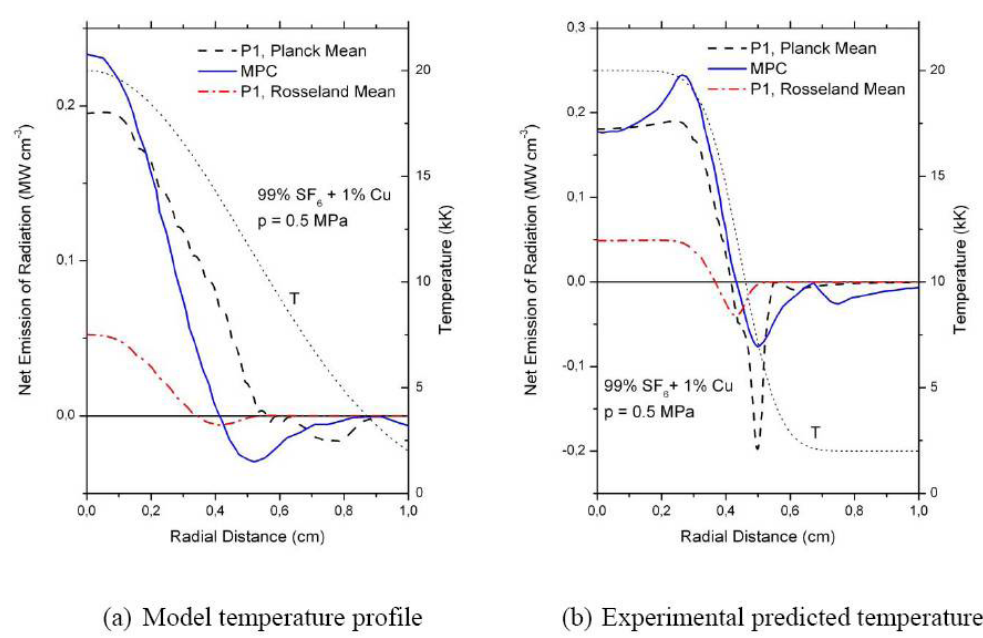
plasma with 1% Cu for two different temperature profiles (dotted line). Comparison of values calculated by P1- Figure 5: Net emission of SF 6 approximation and by the method of partial characteristics (MPC) [1],